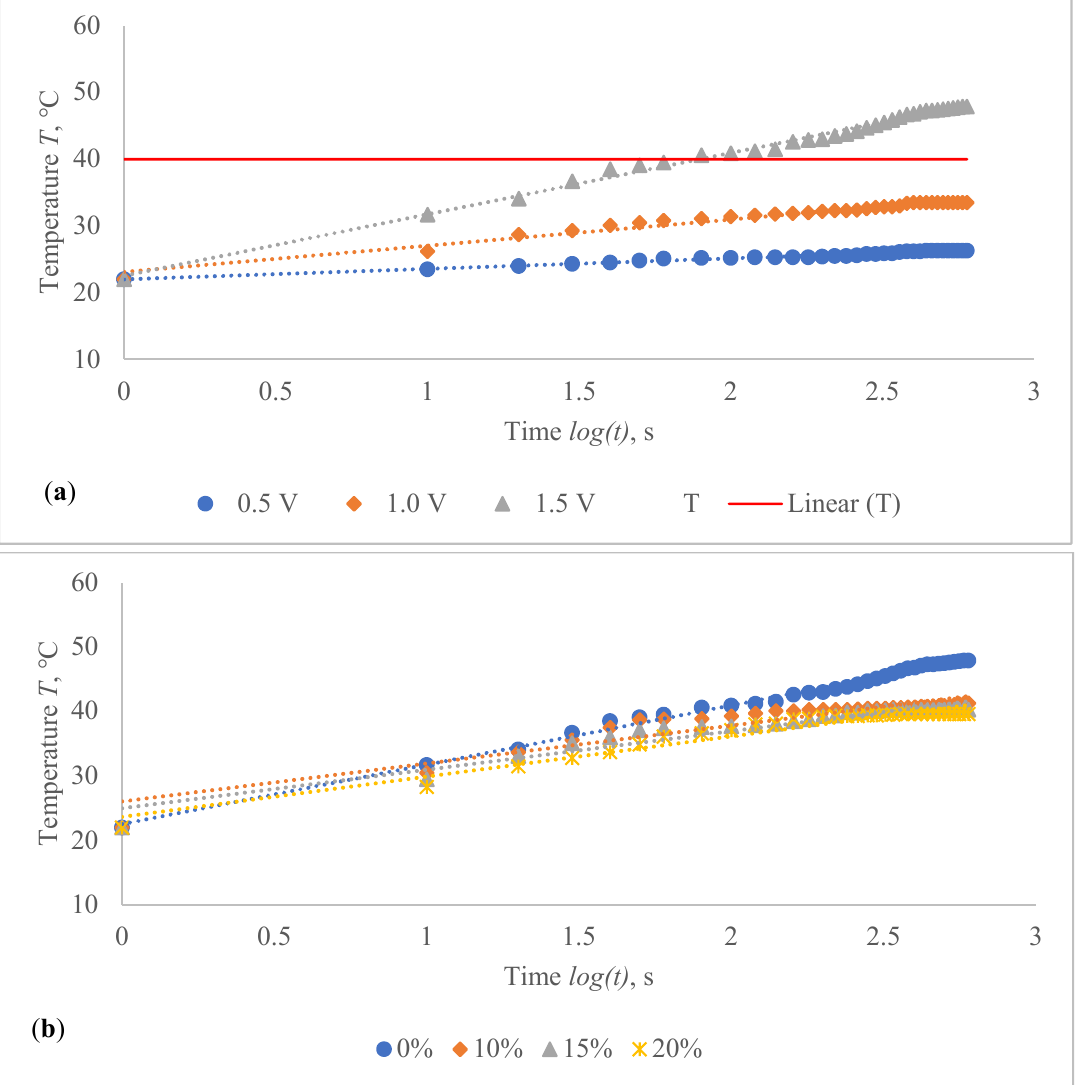
Figure 14. Temperature changes of CF_HY2 structured electro-conductive composite fabric during the 600 s period: ( a ) at non-stretched state by applying different voltage; and ( b ) at the different stretch levels by applying 1.5 V. Red line indicates the target